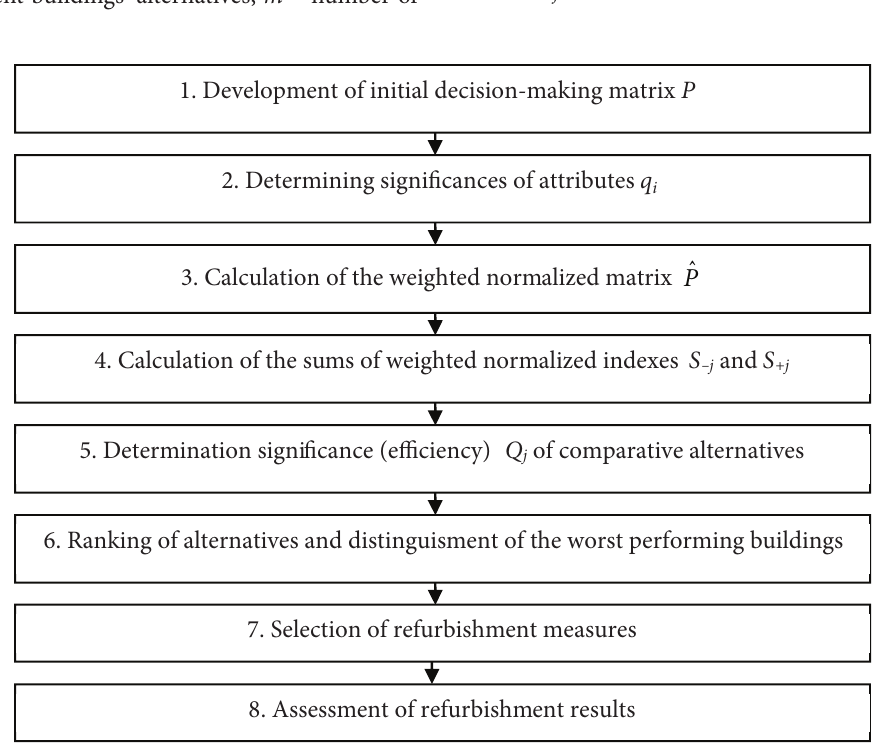
Figure 1. Multiple criteria assessment of buildings’ performance based on COPRAS